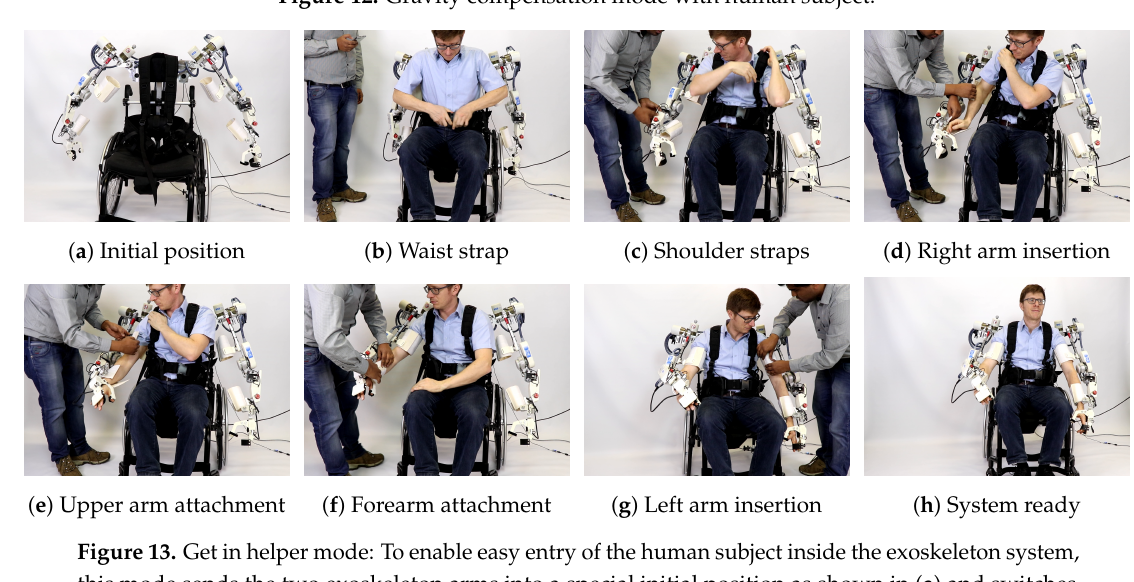
Figure 13. Get in helper mode: To enable easy entry of the human subject inside the exoskeleton system, this mode sends the two exoskeleton arms into a special initial position as shown in ( a ) and switches